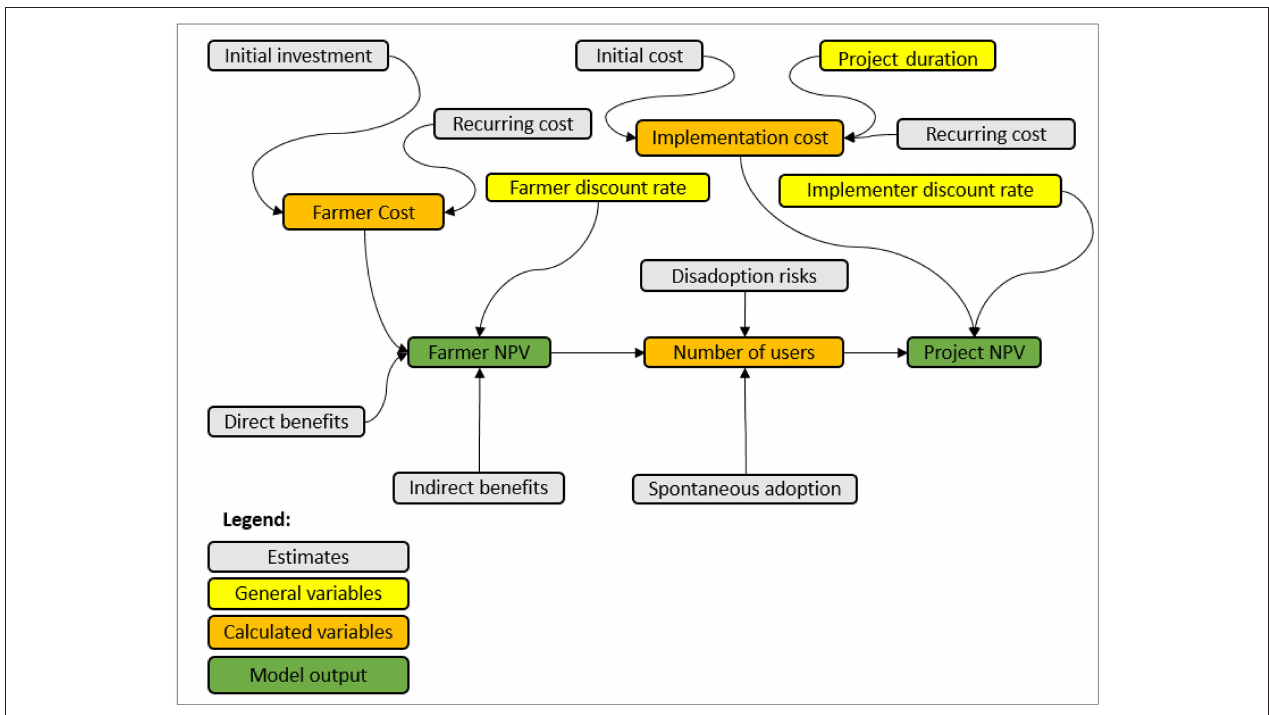
FIGURE 3 | Structure of the decision